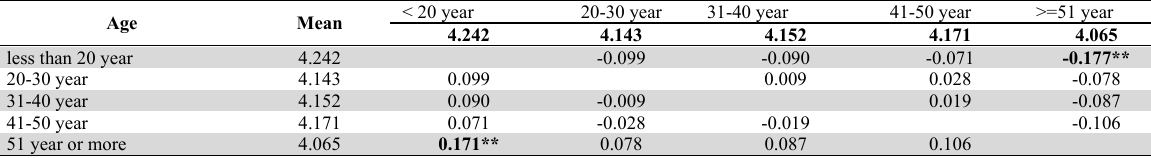
Scheffe test for variances of Ease of use depending on